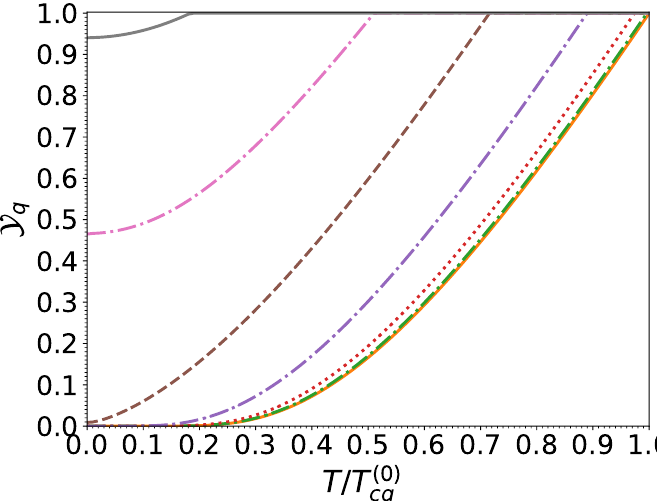
( 0 ) Figure 8. Y q as a function of the normalized temperature T / T cq for different normalized effective ( 0 ) superfluid velocities V q / V cq . The legend of the curves is the same as in Figure 4. The functions Y q are well approximated by the functions Φ q defined by Equation (62) ( 0 ) where the pairing gaps ˘ ∆ q are computed from Equation (59) and provided ˘ ∆ q are evalu- ated from Equation (77). Since the deviations decrease with increasing density, we have focused on the crust-core interface. The absolute errors are found to be at most of order 10 − 3 for Y n and 10 − 4 for Y p . It follows from Equation (67) that the function Y q is universal. In the absence of superflow V q = 0, the temperature dependence of the functions Y q can be well fitted by the following expression [57] (errors not exceeding